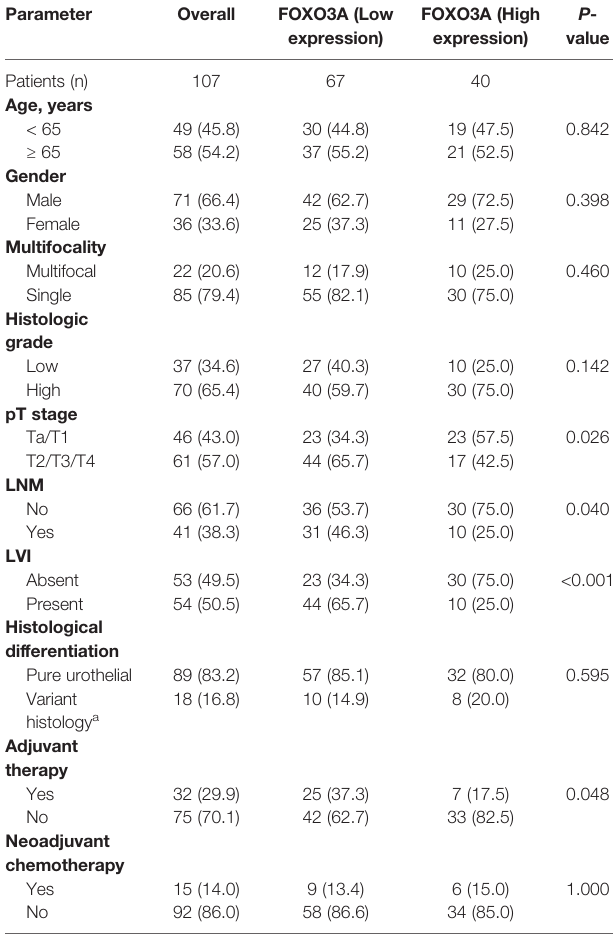
TABLE 1 | Association between FOXO3A expression and UTUC clinicopathological